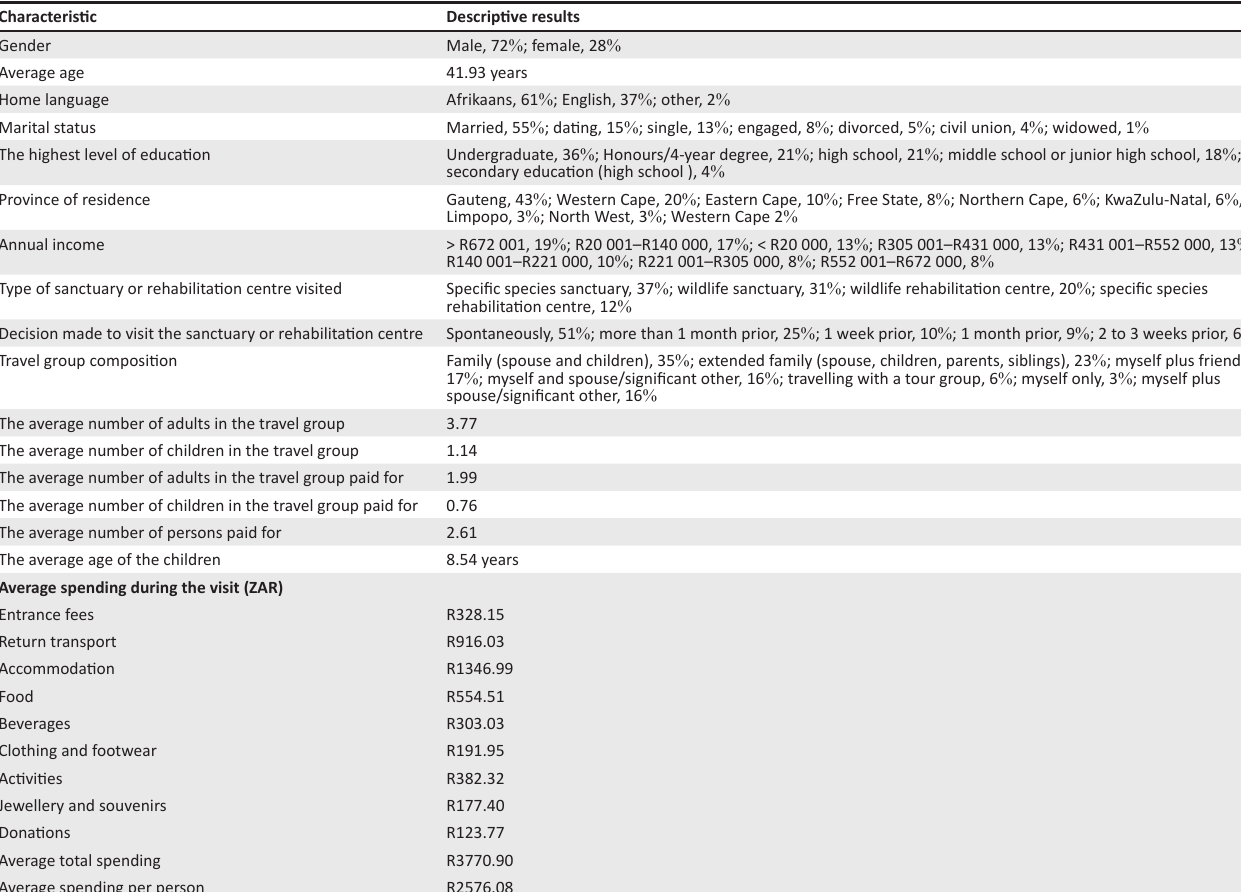
TABLE 2: Respondents’ profiles.